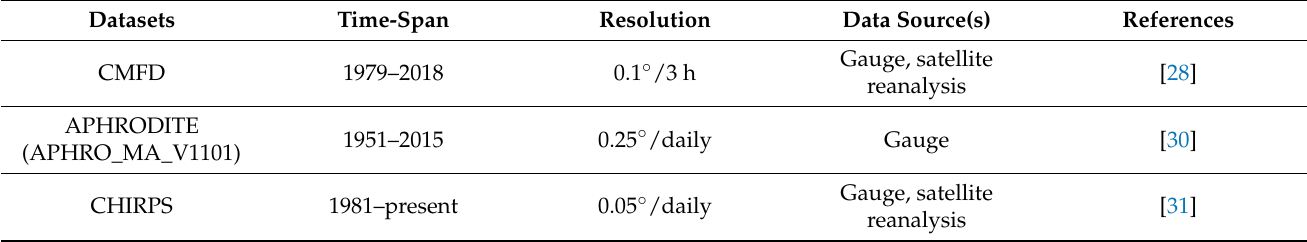
Table 1. Overview of the three gridded precipitation datasets